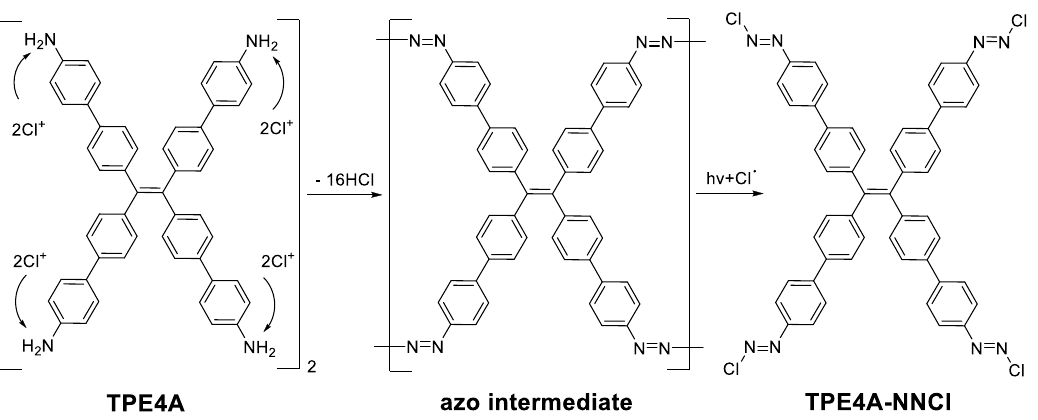
Scheme 2. Possible mechanism of chemosensor TPE4A for ClO −